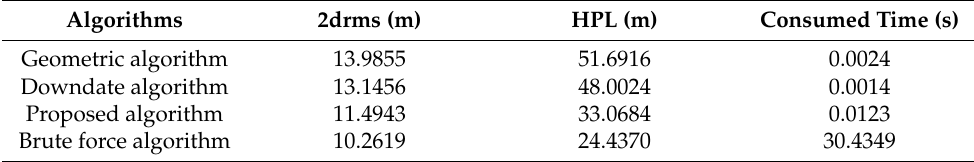
Figure 6. 2drms and HPL of the subset and consumed time of each satellite selection algorithm in the fixed subset size trial. ( a ) 2drms value; ( b ) HPL value; ( c ) Consumed time. Table 4. Average 2drms, HPL and consumed time of each algorithm in the fixed subset size trial.